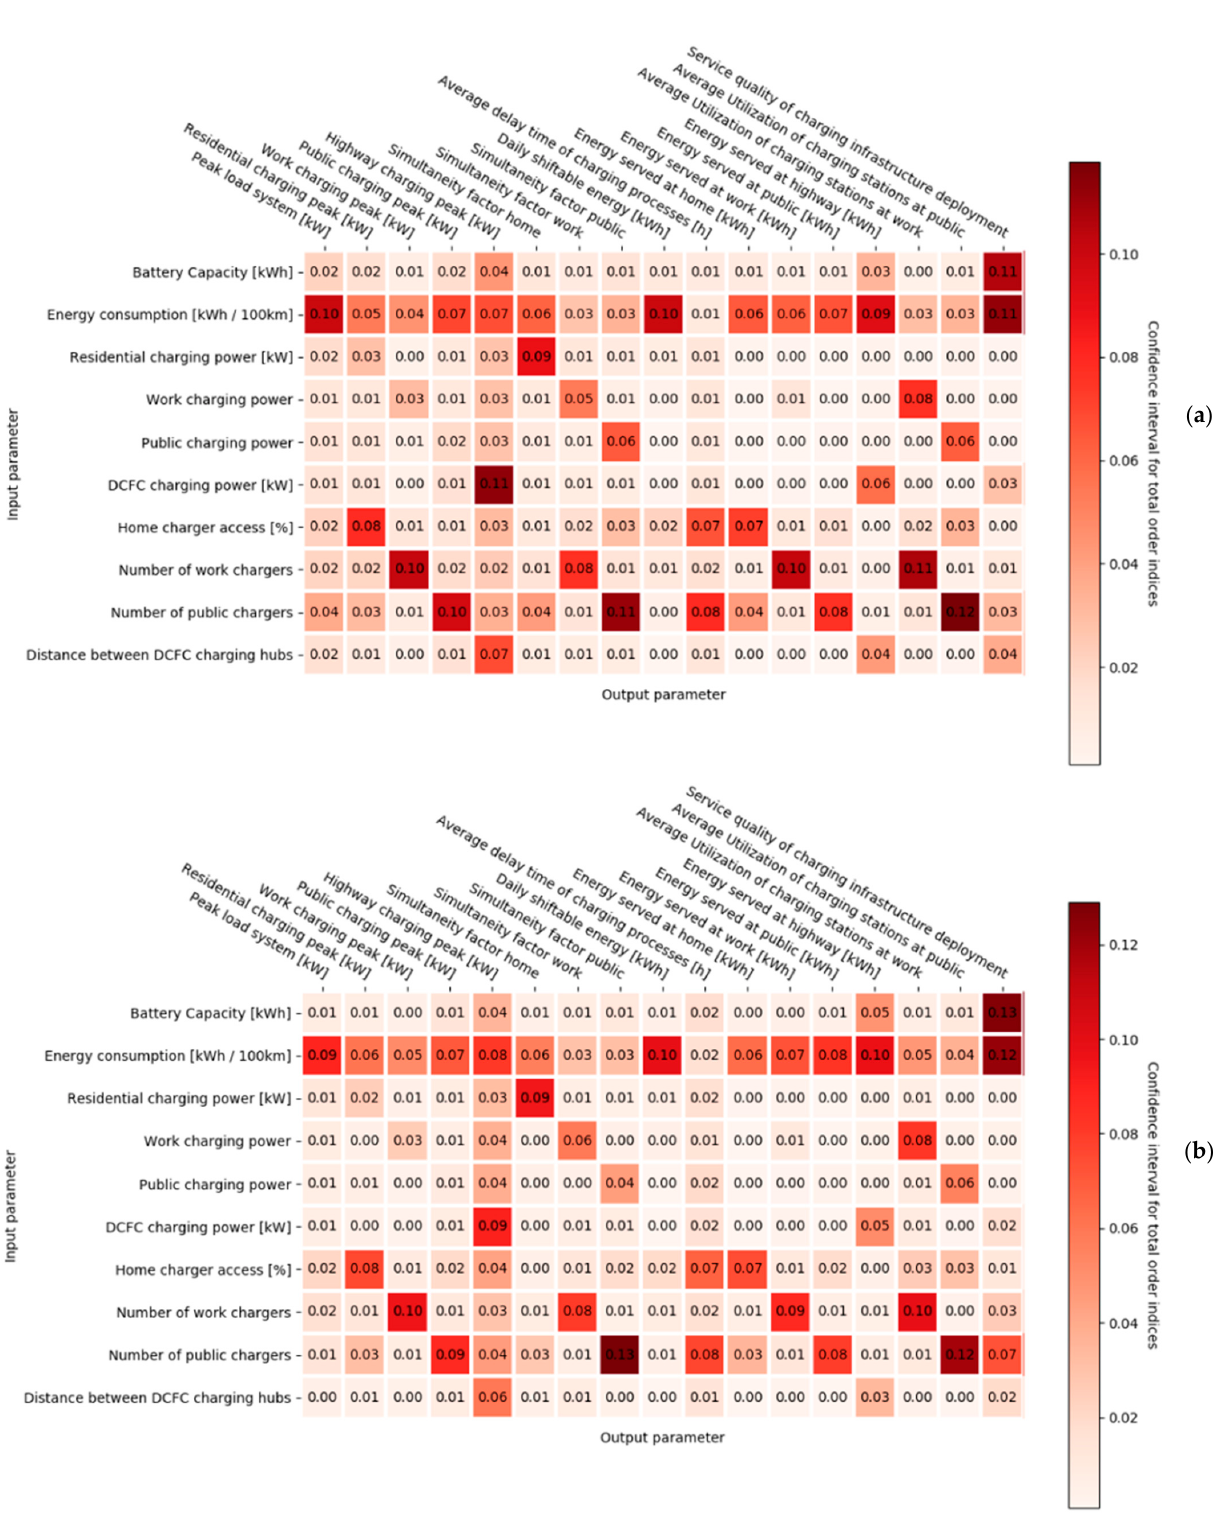
Figure A3. Confidence Intervals of total order Sobol indices obtained from bootstrapping with 100 resamples ( a ) rural and ( b ) urban.